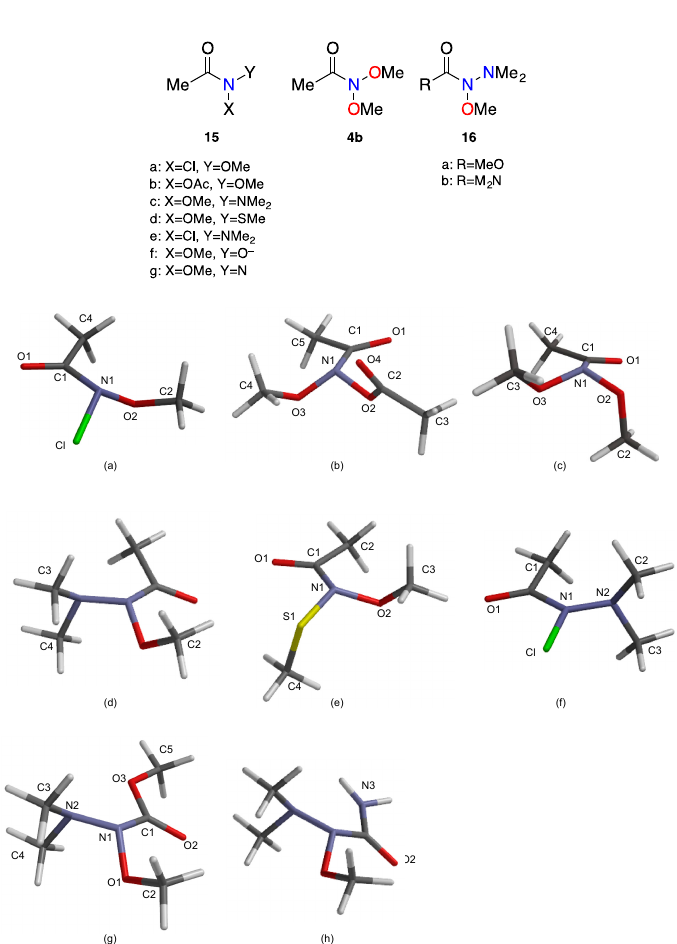
Figure 7. B3LYP/6-31G(d) lowest energy ground state conformers of model anomeric acetamides ( a ) N -chloro- N -methoxyacetamide 15a, ( b ) N -acetoxy- N -methoxyacetamide 15b , ( c ) N,N -dimethoxyacetamide 4b , ( d ) N -methoxy- N -dimethylaminoacetamide 15c , ( e ) N -methoxy- N - methylthiylacetamide 15d , ( f ) N -chloro- N -dimethylaminocetamide 15e , ( g ) O -methyl N -methoxy- N - dimethylaminoacetamide 16a , and ( h ) N -methoxy- N -dimethylaminourea 16b . Table 3. Selected structural data for B3LYP/6-31G(d) lowest energy conformers of model acetamides 4b , 15a – e , and 16a , b . Structure